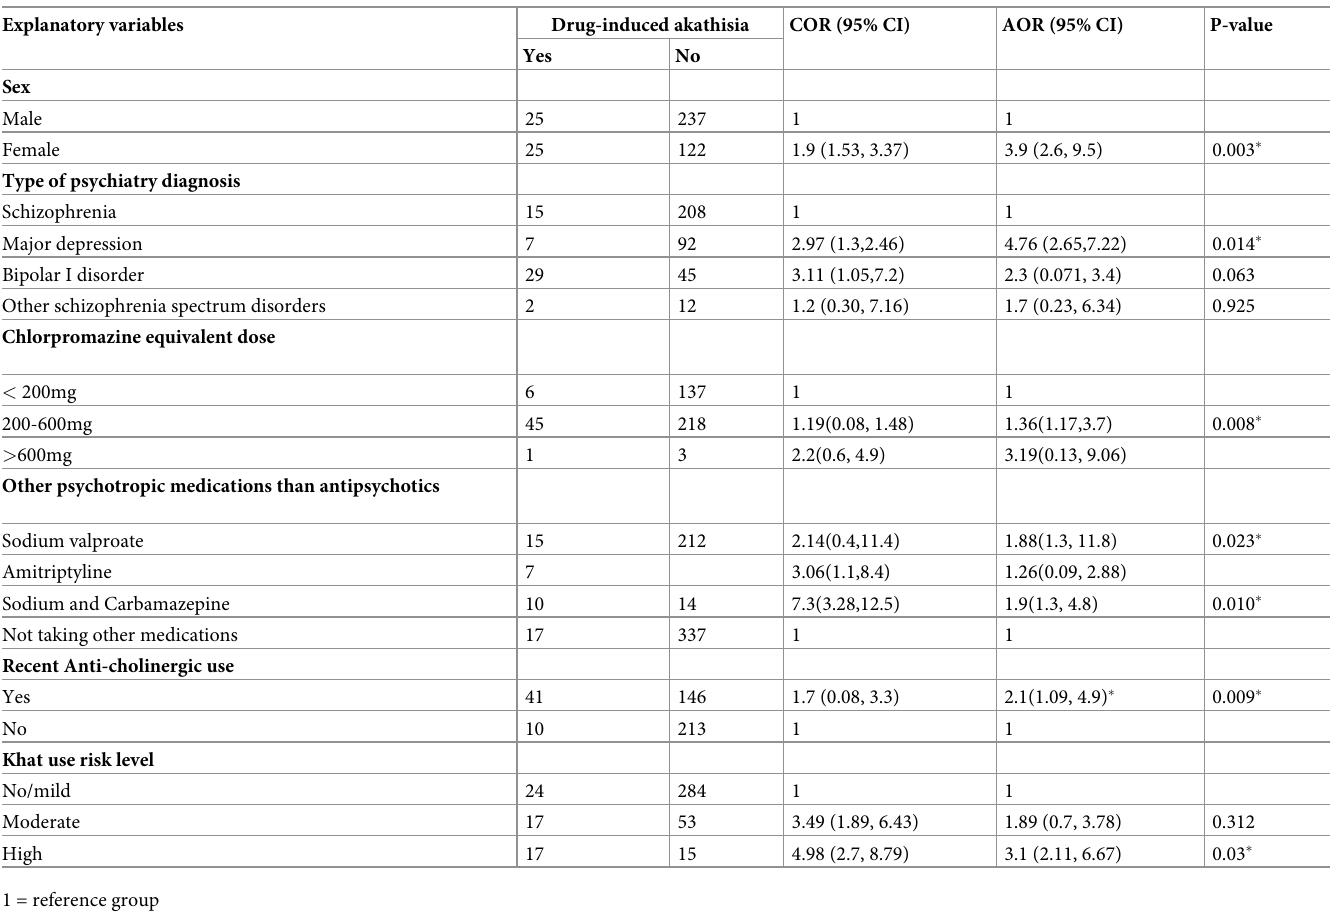
Table 4. Factors associated with drug-induced akathisia among patients taking antipsychotics and attending follow-up treatment at JMC,